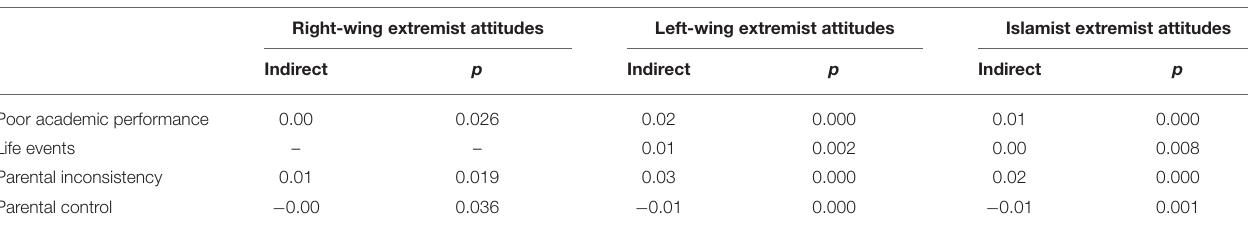
TABLE 1 | Indirect effects via identity diffusion. Right-wing extremist attitudes Left-wing extremist